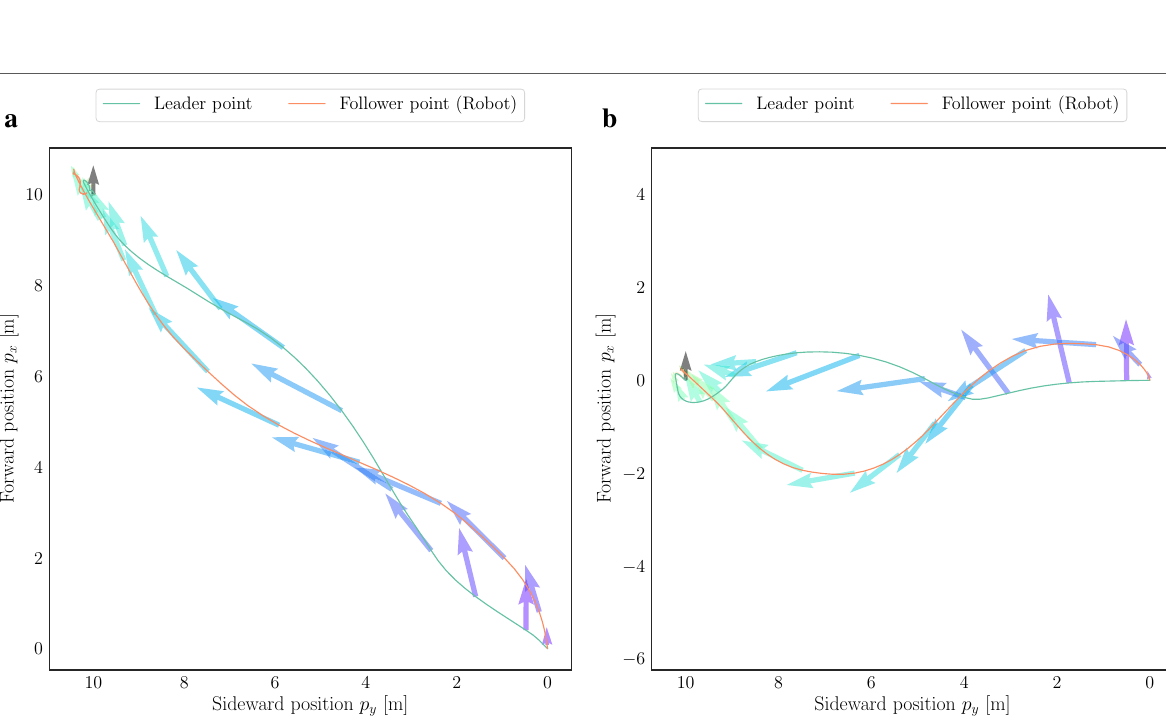
Fig. 4 Examples of the virtual dynamics in three dimensions in both cases, the robot could follow the leader point to the goal, although the distance between them seemed to be far. a Goal: (10 m, 10 m, 0°), b goal: (0 m, 10 m,